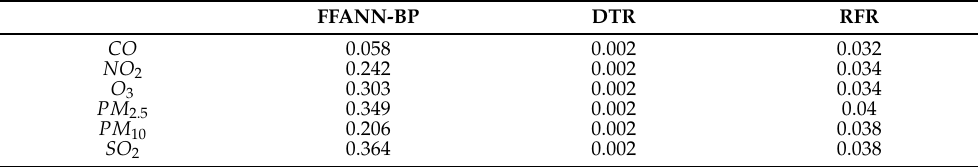
Table 8. The runtime of the three algorithm at Ma Lian Kou in 2016, all in (s).